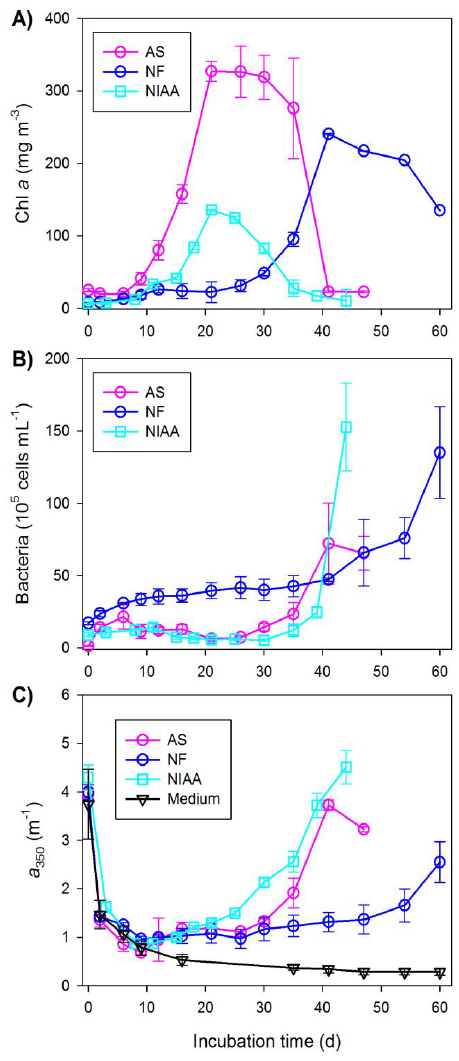
Figure 1. Temporal progressions of chlorophyll a concentration ( A ), bacterial cell abundance ( B ), and the absorption coe ffi cient at 350 nm (a proxy of the abundance of chromophoric dissolved organic matter) ( C ) in the ice algal cultures and medium control. AS stands for Attheya septentrionalis, NF for Nitzschia frigida , and NIAA for natural ice algae assemblage. Error bars are one standard deviation of the triplicate